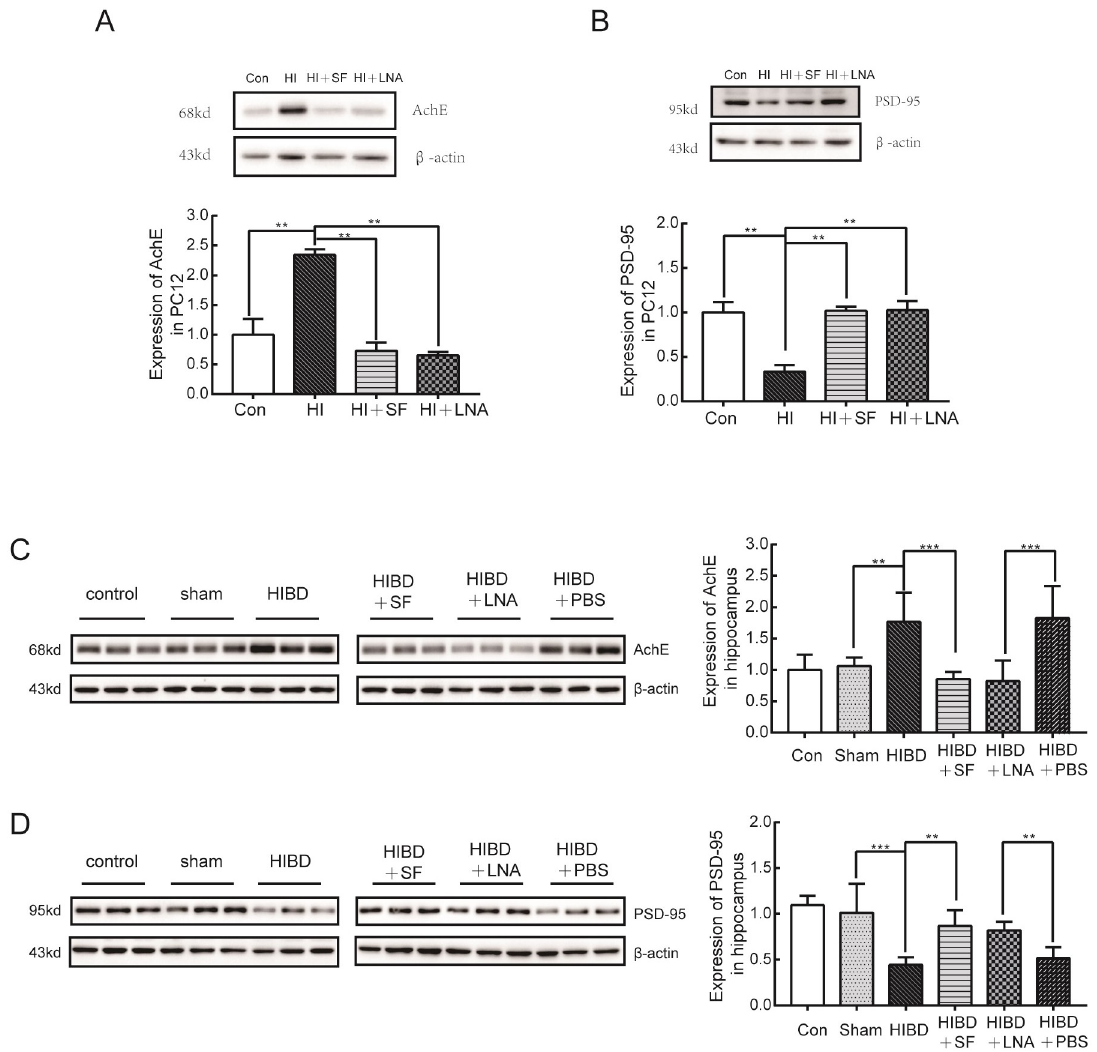
Fig 7. Western blot analysis of the protein expression of AchE and PSD-95 in PC12 cells and rat hippocampus. SF and LNA-miR-9 effectively reversed the expression changes in AchE and PSD-95 caused by ischemic-hypoxic injury. (A) The expression of AchE in PC12 cells. (B) The expression of AchE in the rat hippocampus. (C) The expression of PSD-95 in PC12 cells. (D) The expression of PSD-95 in the rat hippocampus. ��� P < 0.001, �� P < 0.01 vs HIBD or HIBD+PBS. N = 4 for cell analysis and N = 6 for animal